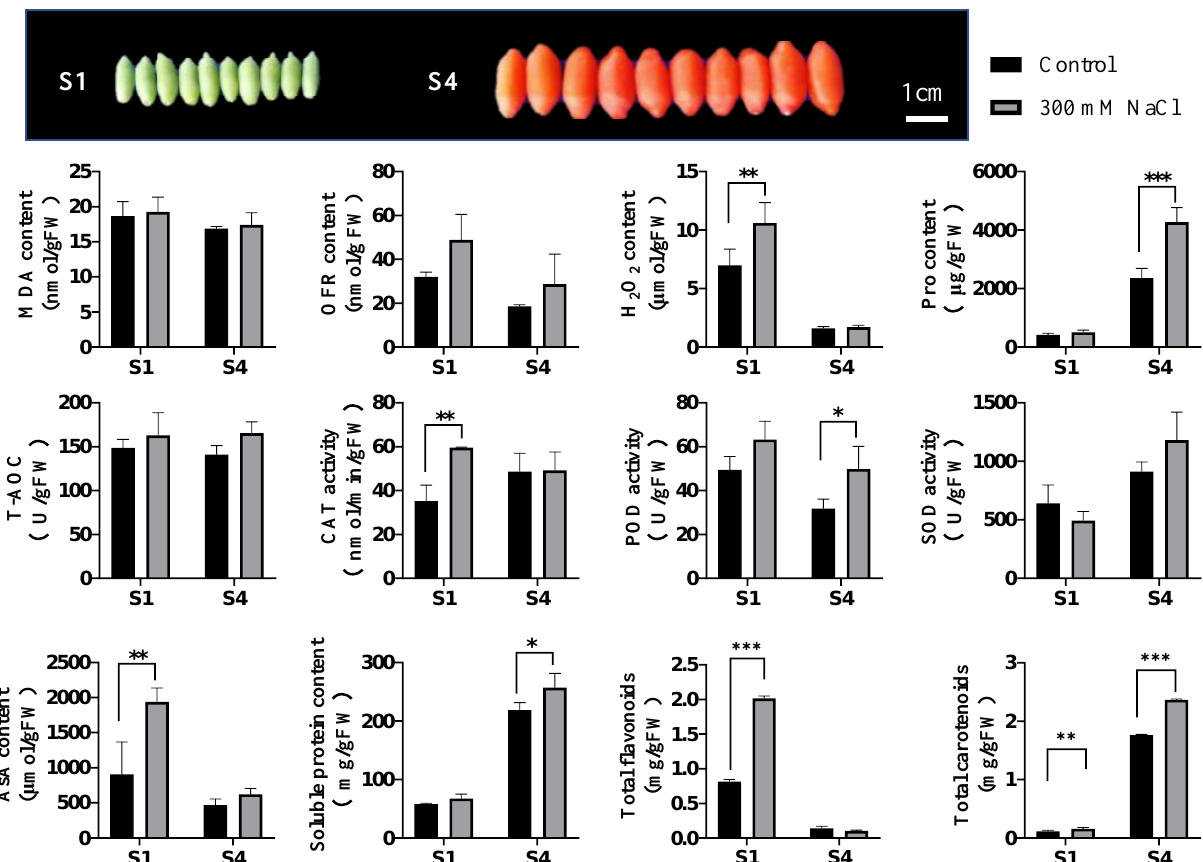
Figure 1. Physiological response of fruits from Lycium barbarum treated with 300 mM of NaCl for three months. Reactive oxygen species (ROS) and oxidation products (including oxygen free radical (OFR), hydrogen peroxide (H 2 O 2 ) and malondialdehyde (MDA)), antioxidant enzymes activities (including superoxide dismutase (SOD), peroxidase (POD) and catalase (CAT)), non-enzymatic antioxidant ascorbic acid (AsA) and total antioxidant capacity (T-AOC) were detected as described in the Materials and Methods. In addition, osmoprotectant proline (Pro) and soluble protein content were also measured. Data presented as mean ± SD, n = 3. Symbols *, ** and *** represent the significance differences at p < 0.05, p < 0.01 and p < 0.001 level, respectively.